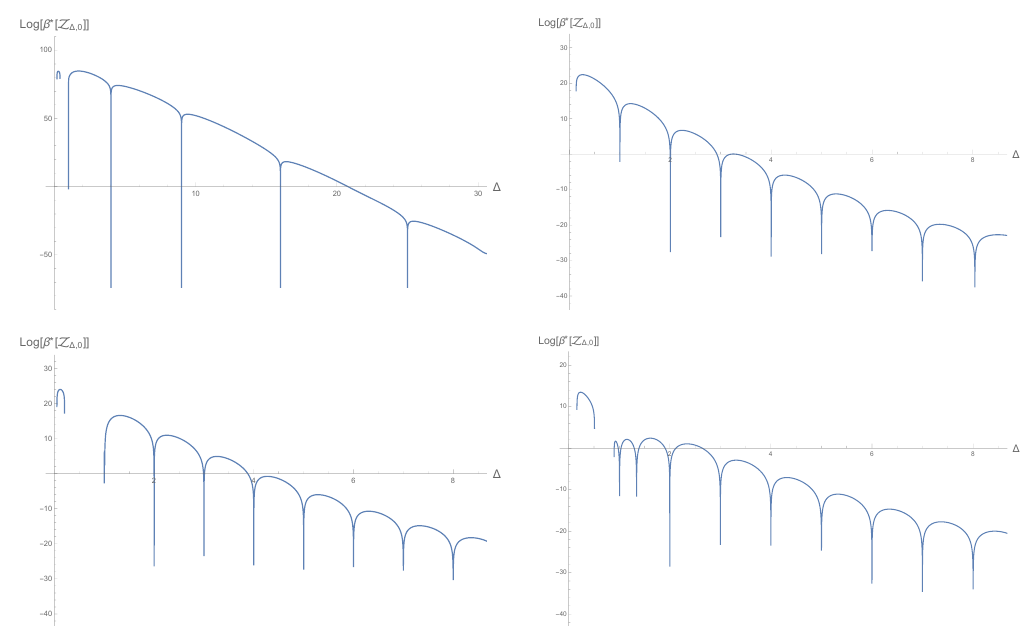
Figure 7 . The extremal functional method applied to the putative CFTs with c = 3 = 2(upper left), 2(upper right), 5 = 2(lower left) and 3(lower right). Four (cid:12)gures are showing the expected spectrum of the scalar states.